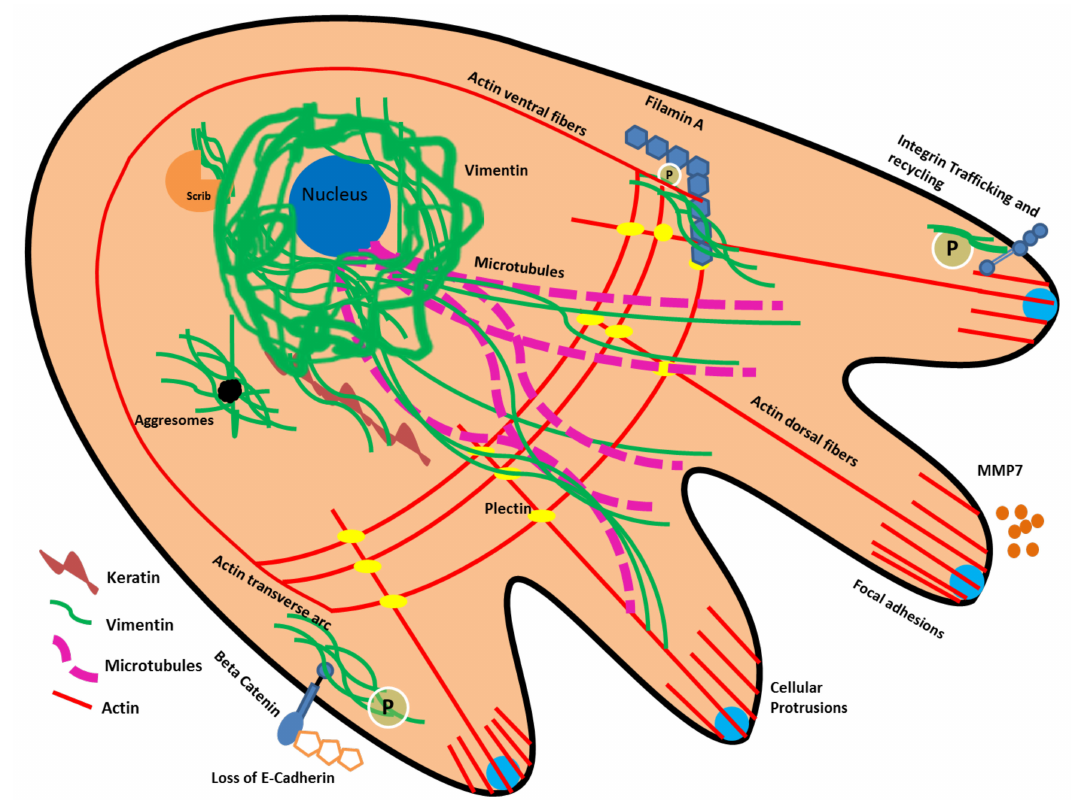
Figure 5. Vimentin works together with other cellular proteins to provide dynamic viscoelastic support to the cell and also actively behaves as a mechanosensor during cell migration in EMT. In migrating cells, it supports the functional role of cytoskeletal proteins, such as actin, microtubules and keratins, formation of new focal adhesions via integrins, ECM degradation via MT1-MMP, and the loss of intercellular junctions via EMT transcriptional regulators, such as Snail/Slug/Twist/Zeb1/2. In addition, it protects Scrib from proteasomal degradation and maintains its protein levels, thus supporting the cell migration through Scrib. Furthermore, it helps the cancer cells to survive internal stress by directly binding to stress granules and aggresomes, therefore supporting their subsequent